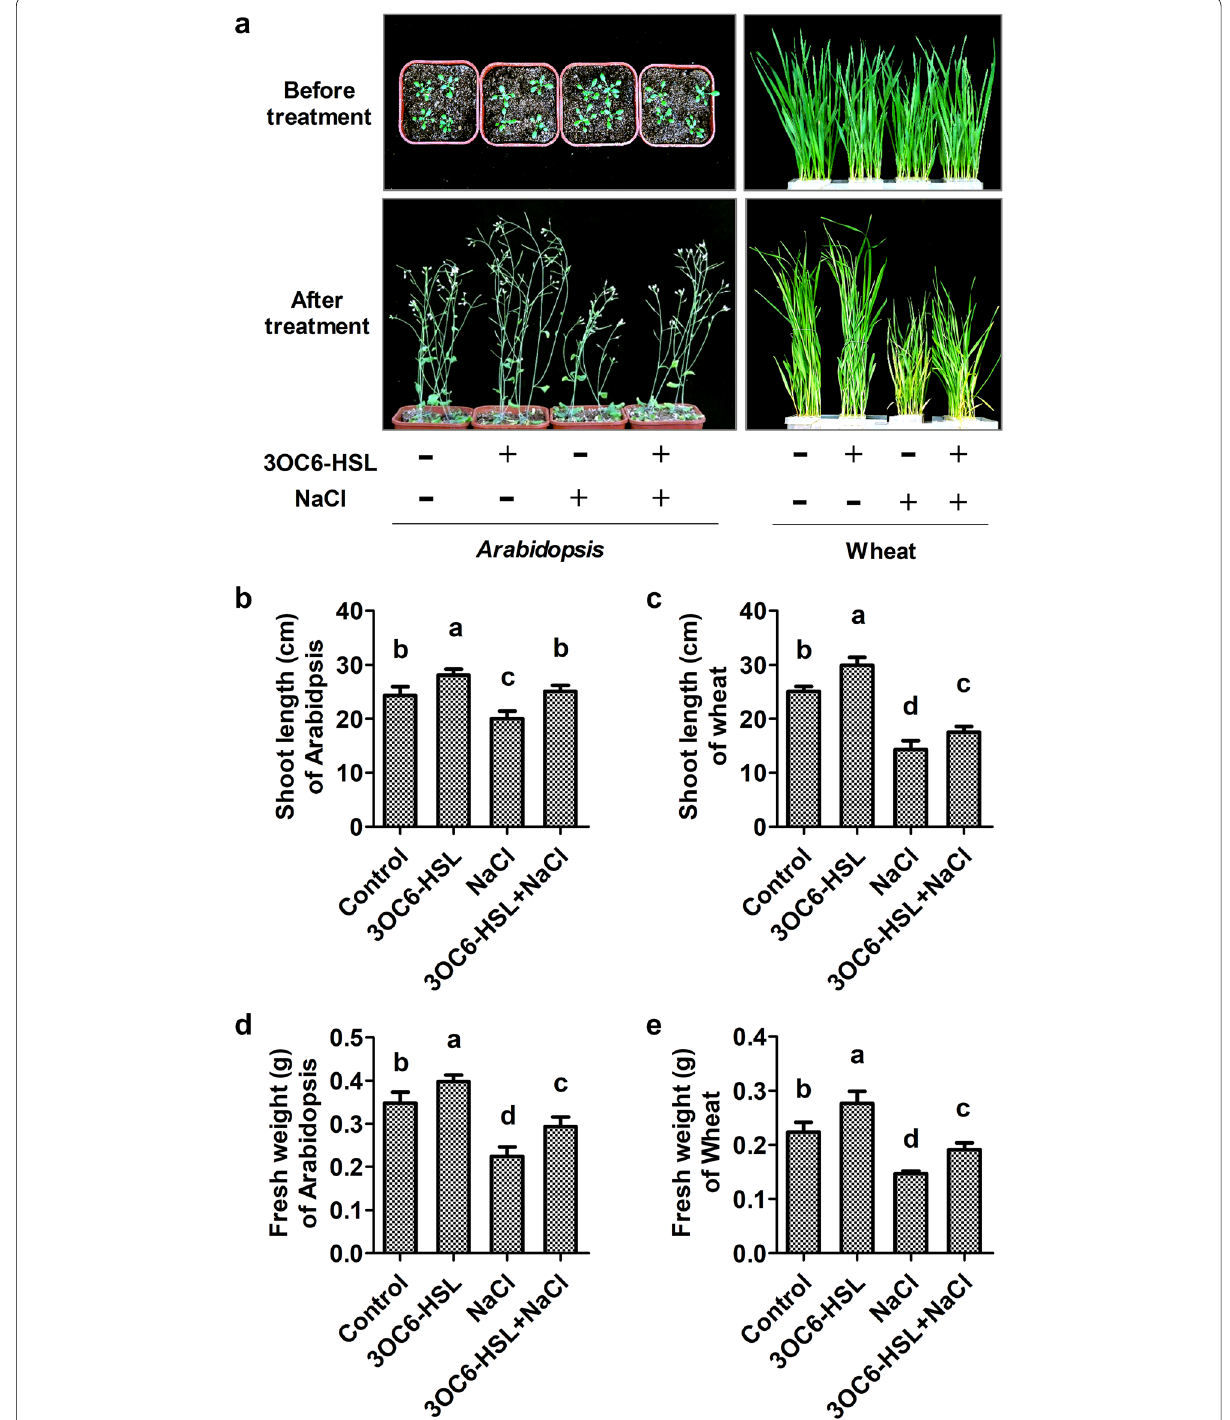
Fig. 1 Effect of 3OC6‑HSL on plant growth in Arabidopsis and wheat. 2‑week‑old seedlings were treated with 1 μM 3OC6‑HSL or/and 150 mM NaCl as indications. The changes of plant growth phenotype were observed after treatment for 14 days in Arabidopsis and 10 days in wheat. a Plant growth status; b shoot length of Arabidopsis; c fresh weight of Arabidopsis; d shoot length of wheat; e fresh weight of wheat. Values are mean of four independent experiments. Different letters indicate statistically significant differences ( P < 0.05, Duncan’s